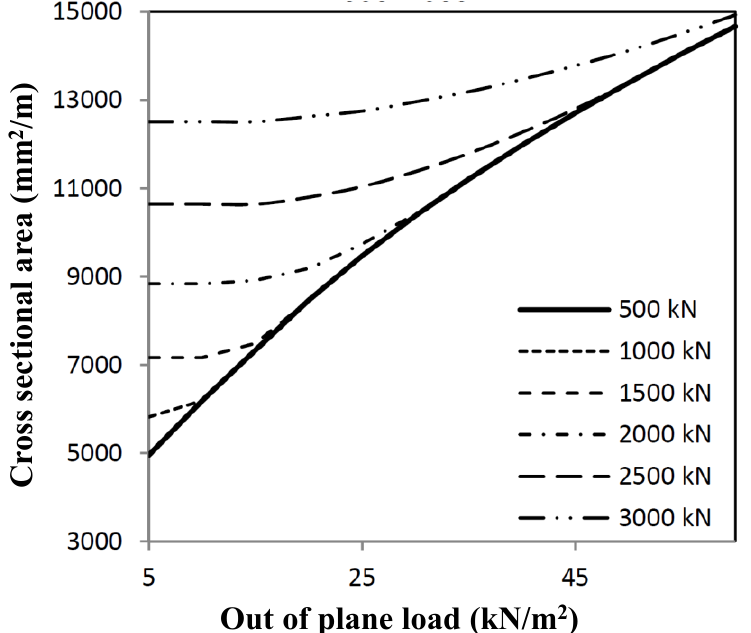
Figure 7. Minimum cross-sectional area for shear loading dependent on the out-of-plane